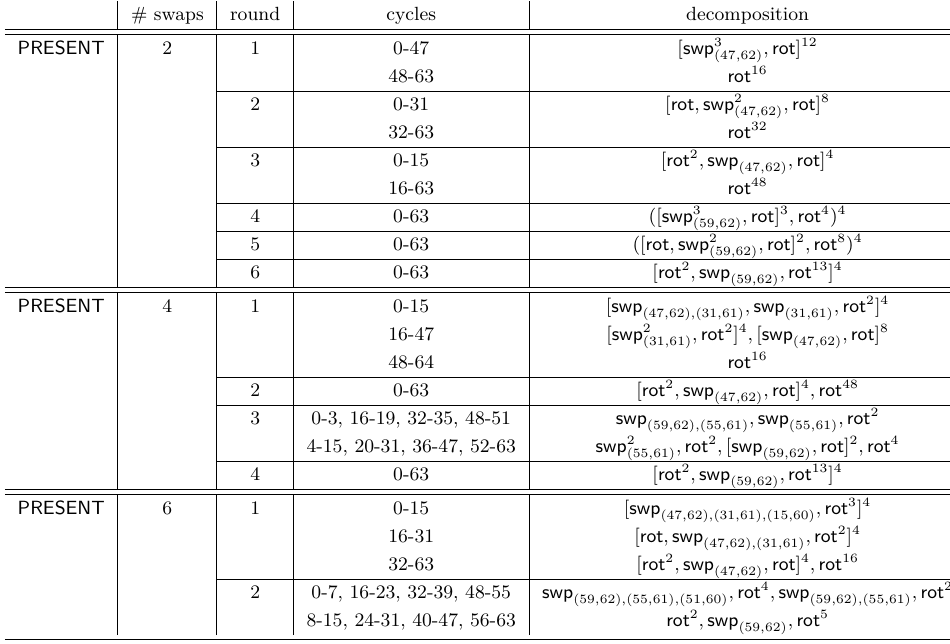
Table 9: Cycle vs. Mux trade-off for